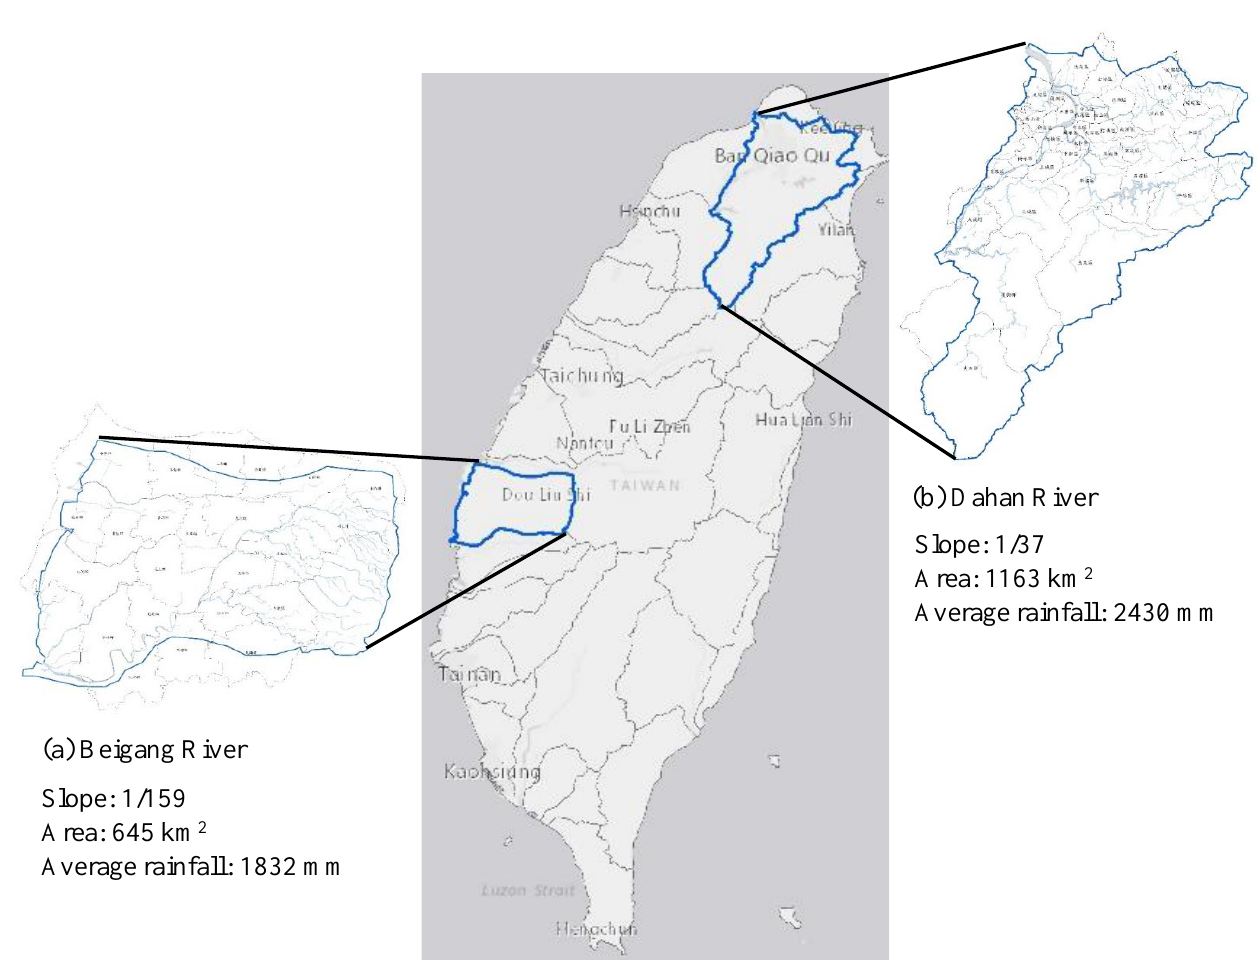
Figure 2. Location of the ( a ) Beigang River; ( b ) Dahan River.